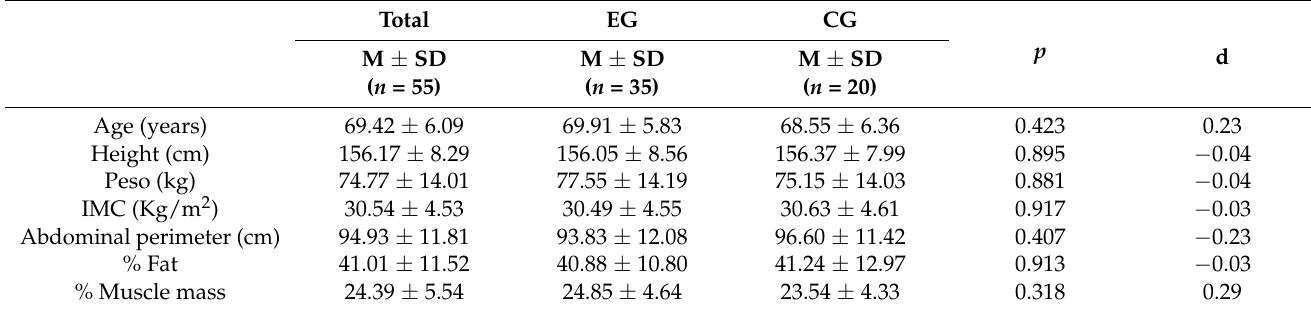
Table 1. Descriptive data of the sample according to the assigned training